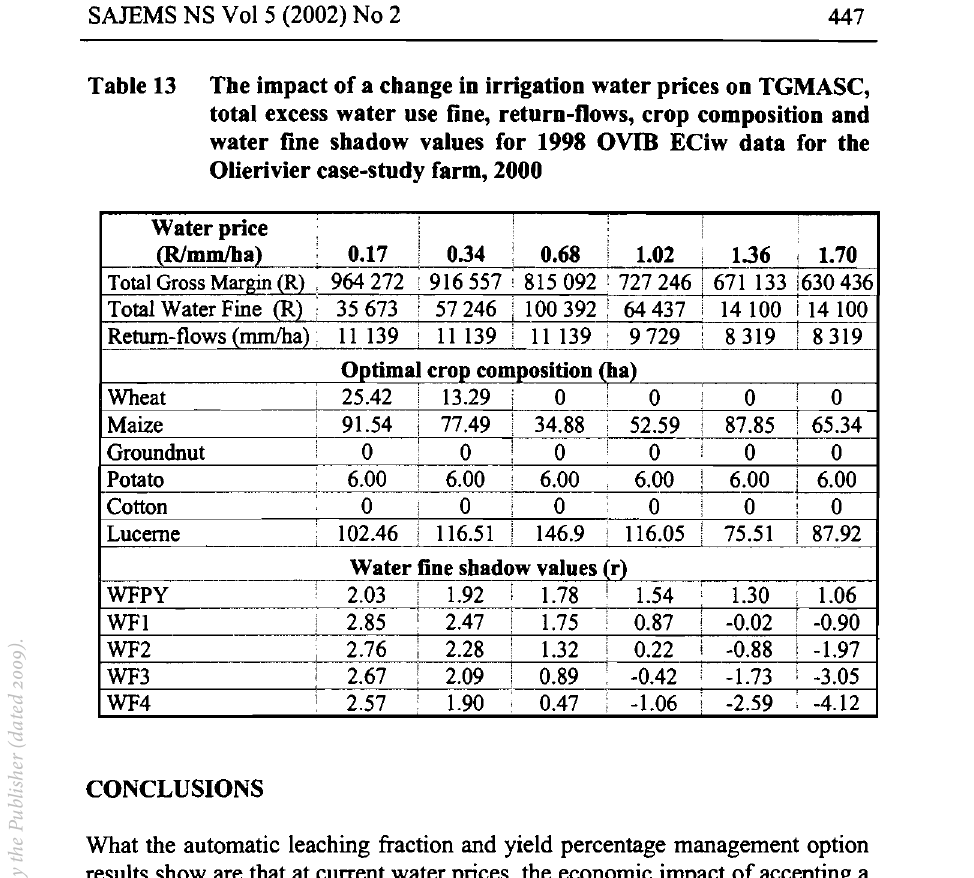
The impact of a change in irrigation water prices on TGMASC, total excess water use fine, return-flows, crop composition and water fine shadow values for 1998 ovm ECiw data for the Olierivier case-study farm, 2000 Water